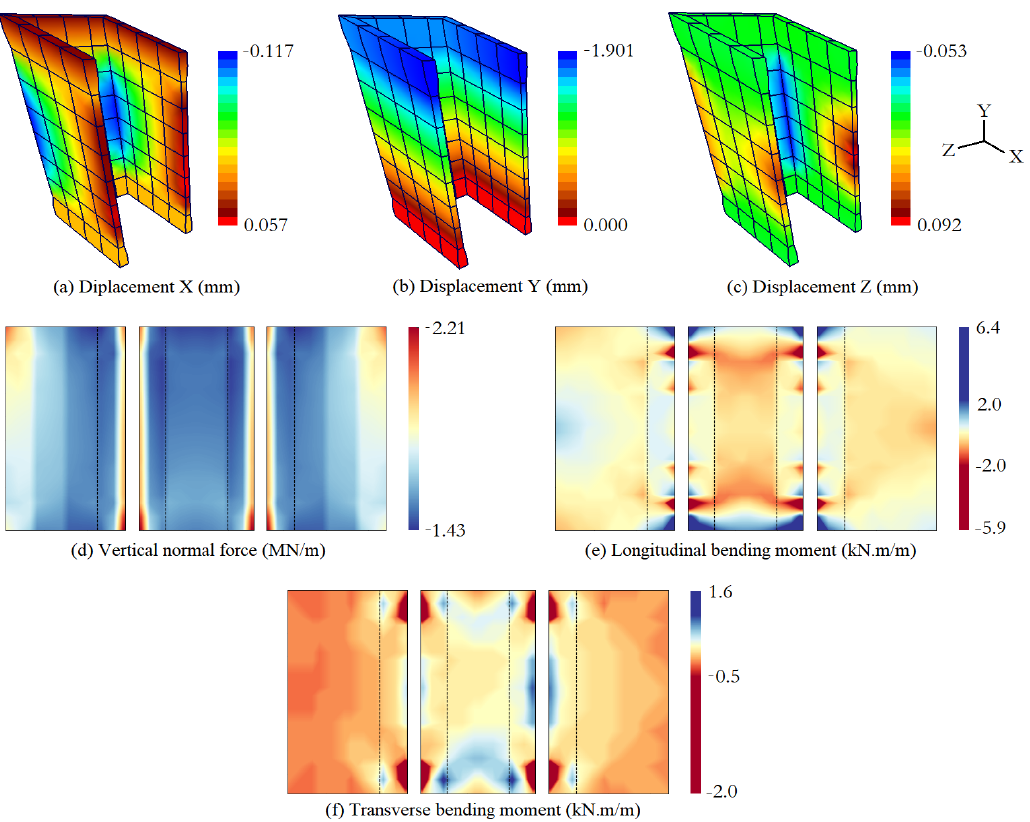
Figure 15. U- shaped shear wall results (asymmetric), lateral planar wall segment λ =